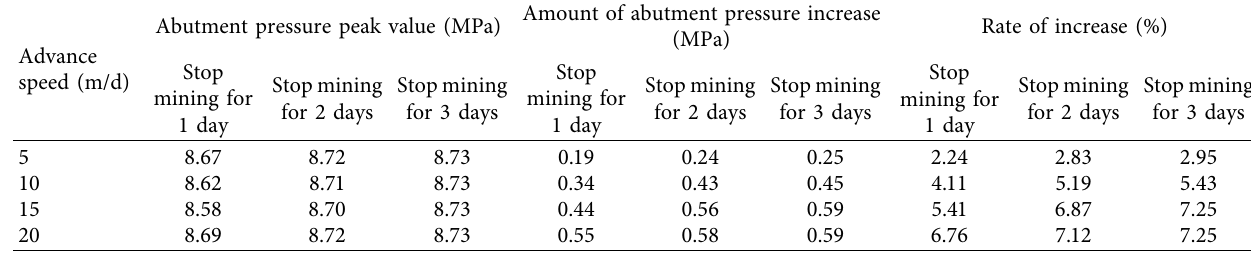
Table 6: Concentration characteristics of stoppage pressure at different rates of advance: line